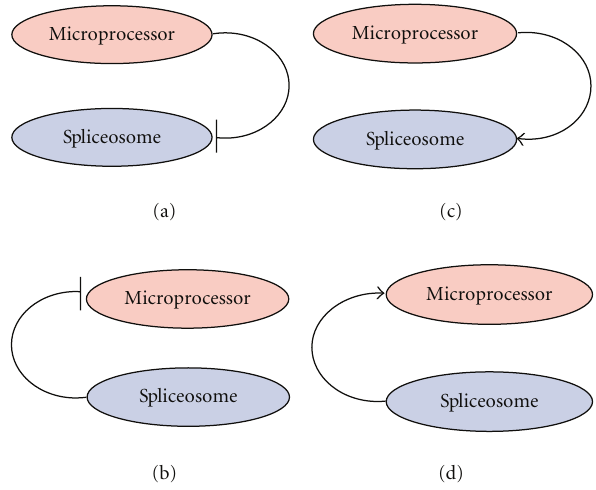
Figure 3: Possible crosstalk models between the miRNA biogenesis process, carried out by the Microprocessor, and the pre-mRNA splicing reaction, carried out by the